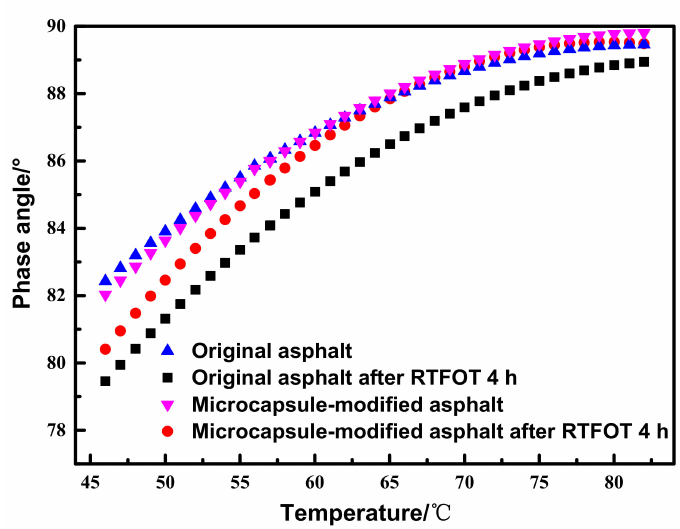
Figure 12. The phase angle of different asphalt samples before and after RTFOT